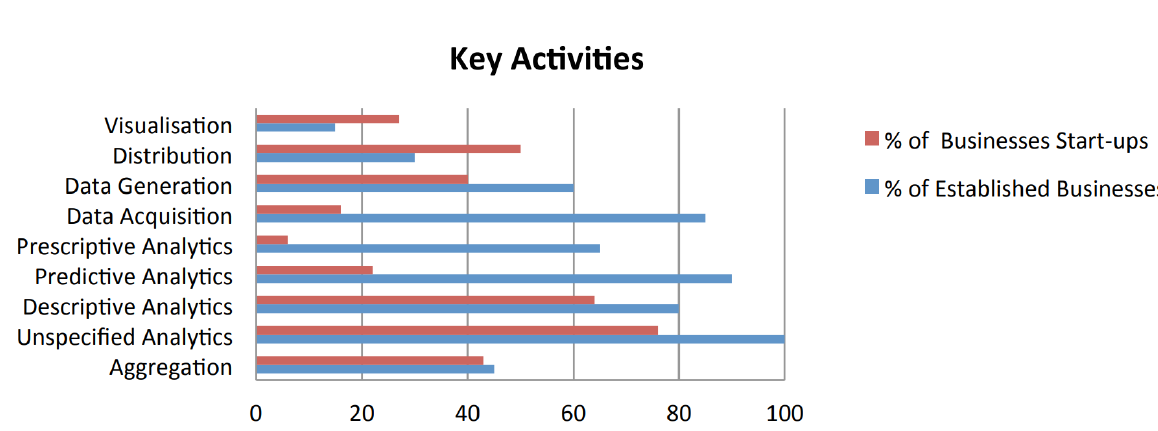
Figure 1: Key activities employed by established businesses as well as business start-ups to process as well as application of